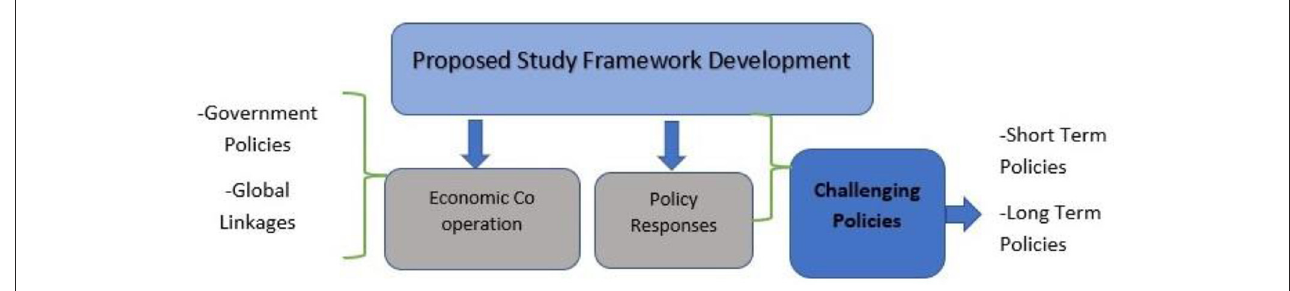
FIGURE13 The proposed study framework for significant development. Source: Author’s development.